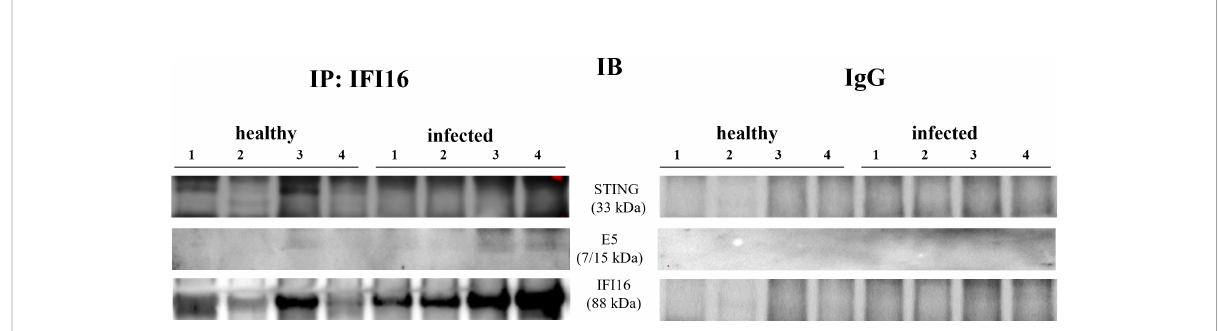
FIGURE 5 IFI16 immunoprecipitation assay. IFI16 interacted with STING and E5 oncoprotein. The corresponding immunoprecipitation using rabbit IgG is shown at